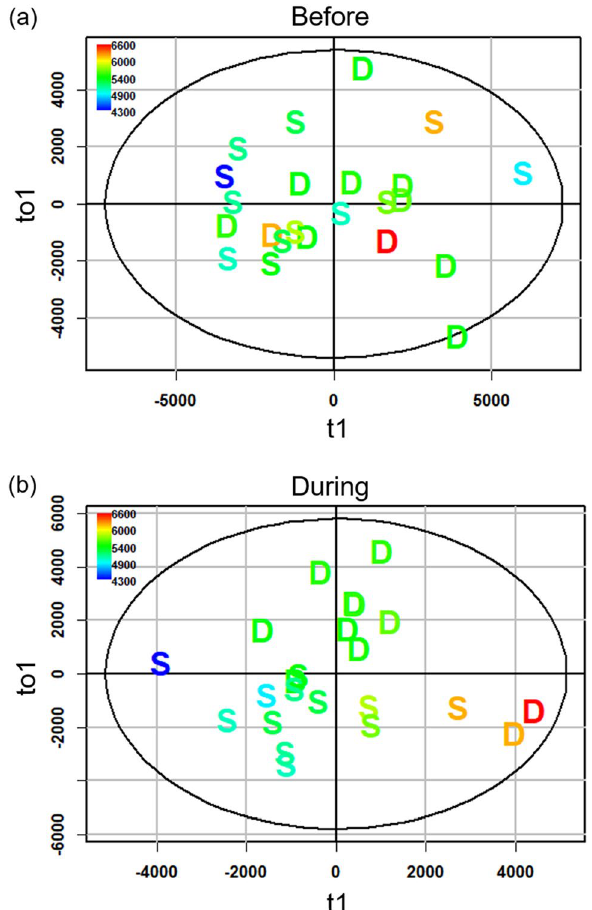
Figure 4. Male VOC expression in relation to urinary protein concentration. OPLS scores plots of total urinary protein concentration based on candidate MS-data derived from denatured male urine (n = 23) collected before ( a ) and during ( b ) the enclosure phase. The x-axis of the scores plot is the predictive component (t1) and the y-axis is the first orthogonal component (to1). Data points for dominant and subordinate males are labelled D and S, respectively. Coloration of the data points indicate the range of urinary protein concentration (µg mL −1 ); high and low concentration range from red to blue,